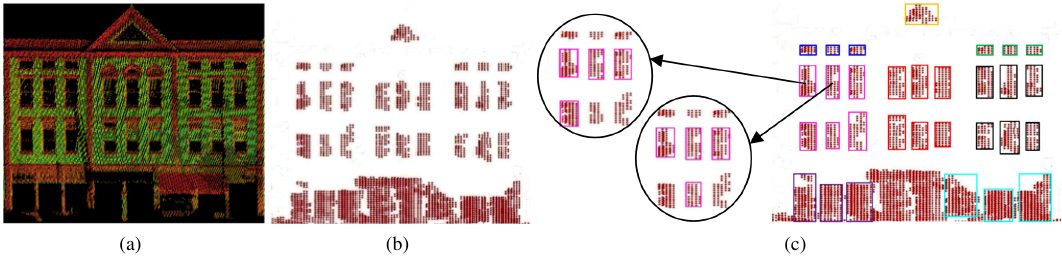
Figure 3: (a) 3D points of building fac¸ade. (b) Potential window candidates after point inversion and window segmentation. (c) Symmetrical correspondences in both row and column for window 1 and 2 respectively. Same colors (of the bounding box) represent similar